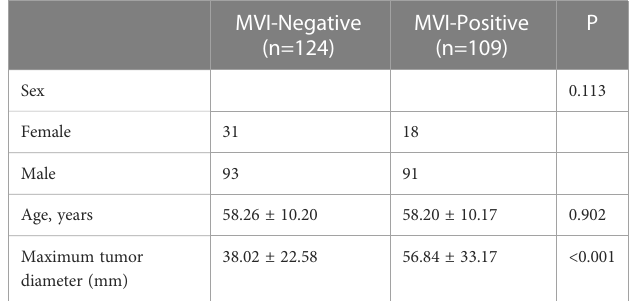
TABLE 1 The demographic features between MVI positive and MVI negative groups.